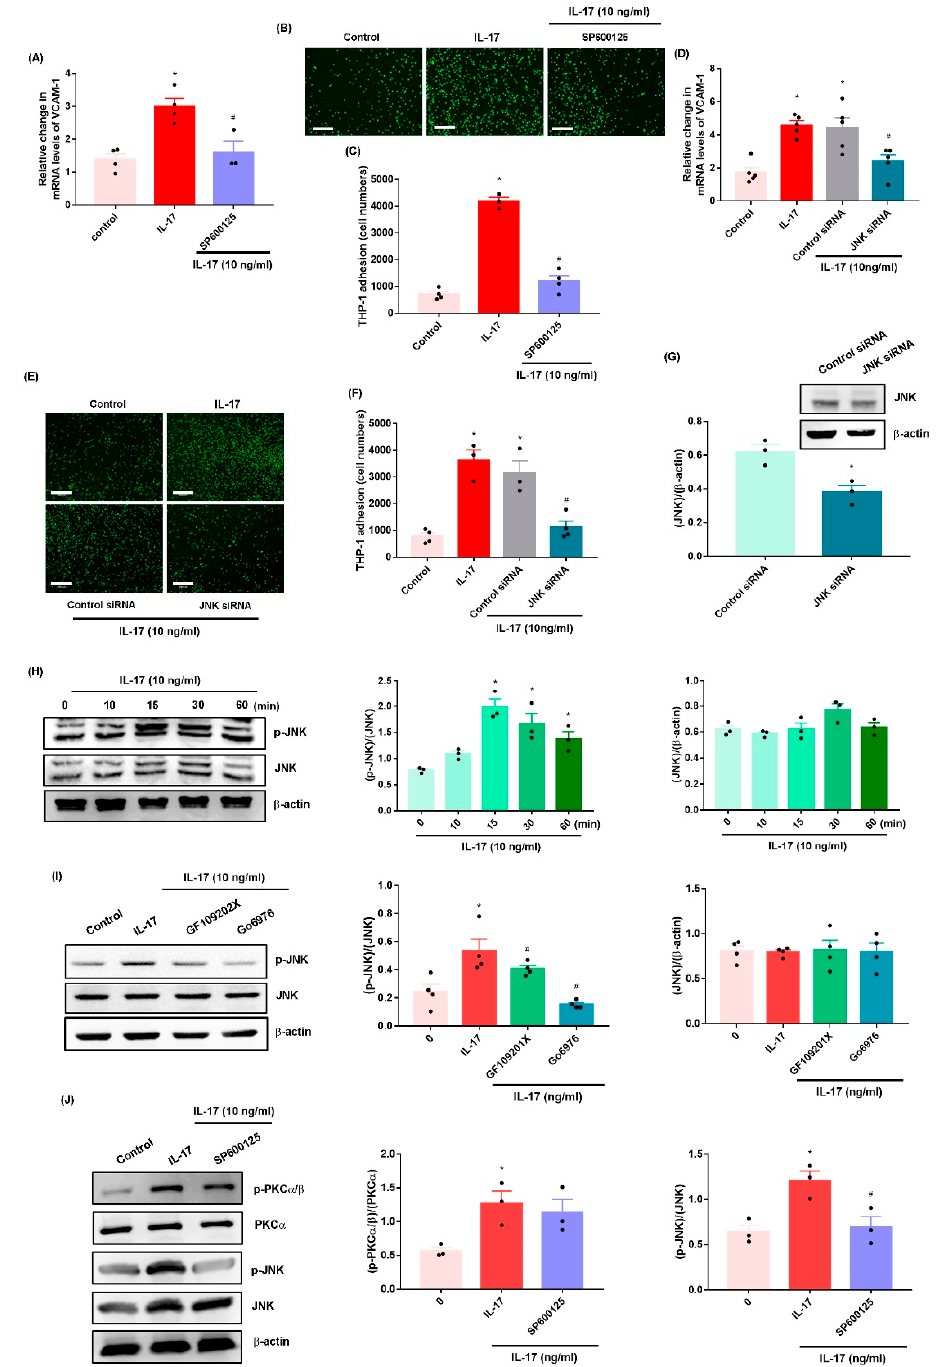
Figure 4. The JNK pathway mediates IL-17-induced promotion of VCAM-1 synthesis and mono- cyte adhesion in OASFs. ( A , D ) OASFs were stimulated with a JNK inhibitor (SP600125, 10 nM) for 30 min or transfected with a JNK siRNA for 24 h and then treated with IL-17 (10 ng/mL) for 24 h. VCAM-1 levels were quantified by qPCR. ( B , C , E , F ) Adherent THP-1 cells were photographed and quantified under fluorescence microscopy. ( G ) JNK protein levels were measured by Western blot. ( H – J ) OASFs were stimulated with IL-17 for the indicated time intervals or pretreated with PKC or JNK inhibitors and then incubated with IL-17 (10 ng/mL). JNK or PKC phosphorylation was performed by Western blot. Size bar = 320 µ m. * p < 0.05 compared with the control group; # p < 0.05 compared with the IL-17-stimulated group.